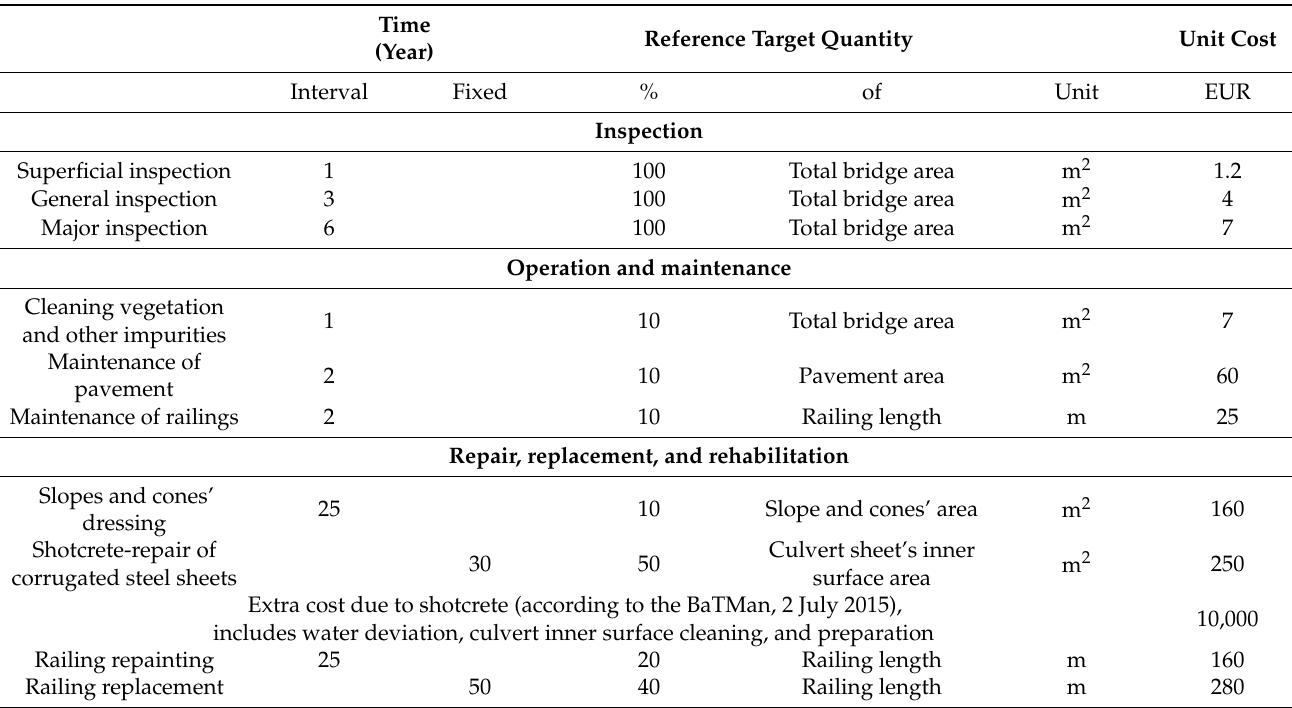
Table 5. Operation and maintenance activities required for steel culvert